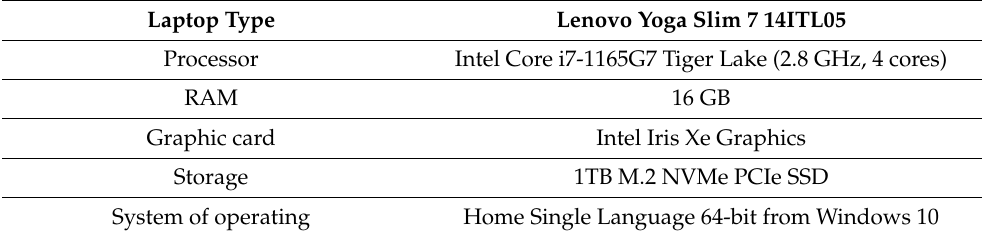
Table 3. Computer and software specification